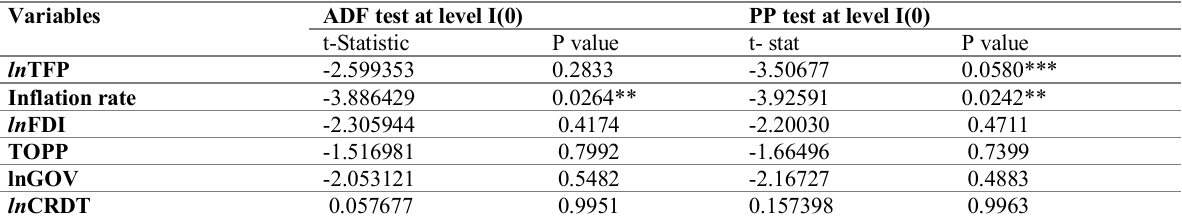
Table 1: Unit root test results of ADF and PP test at level I(0)